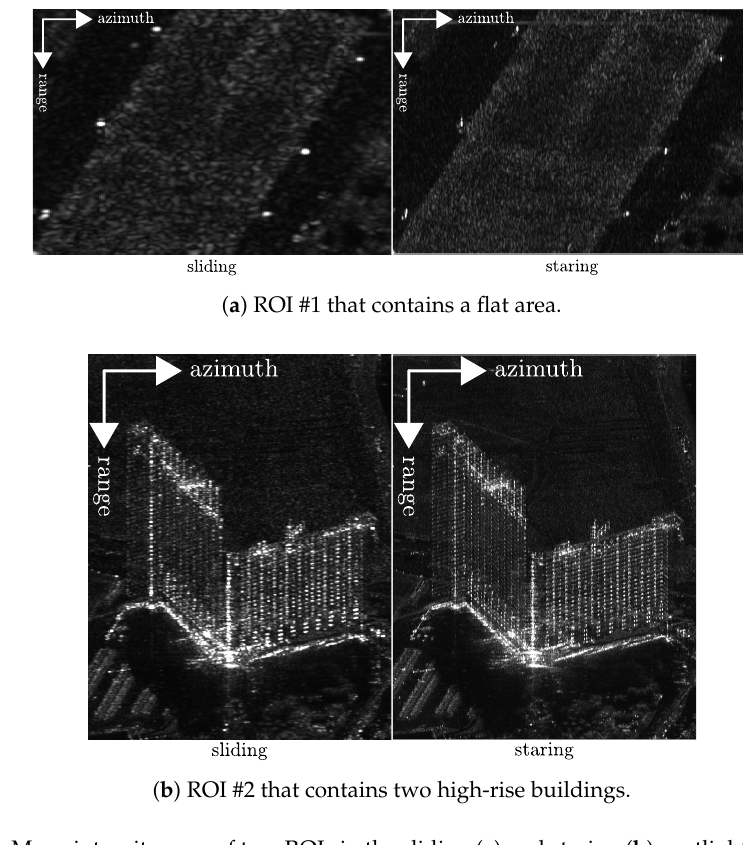
Figure 5. Mean intensity map of two ROIs in the sliding ( a ) and staring ( b ) spotlight modes